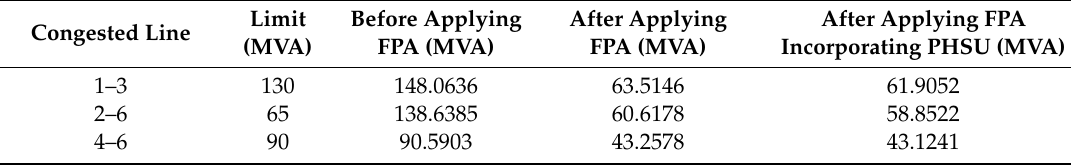
Figure 14. FPA-based cost comparison with and without placement of PHSU for managing congestion. Table 11. FPA-based MVA line flow with and without PHSU. Congested Line